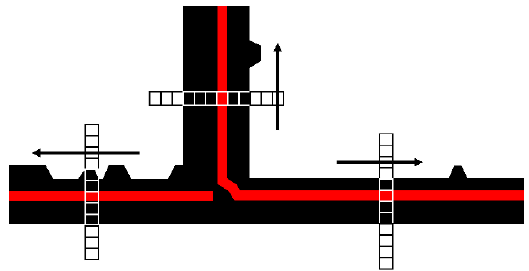
Figure 5. Restoring wall thickness using the moving kernel method.